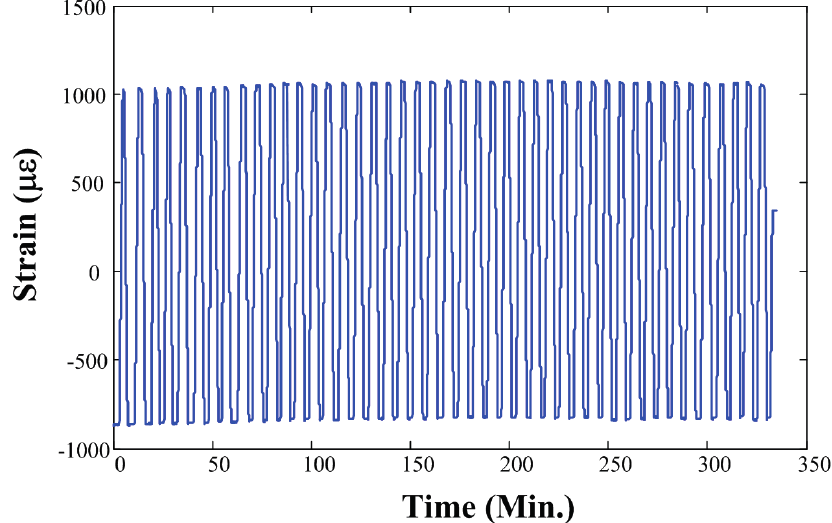
Figure 6. Strain in repeated experiments with alternative forces of 20 kN and 45 kN.